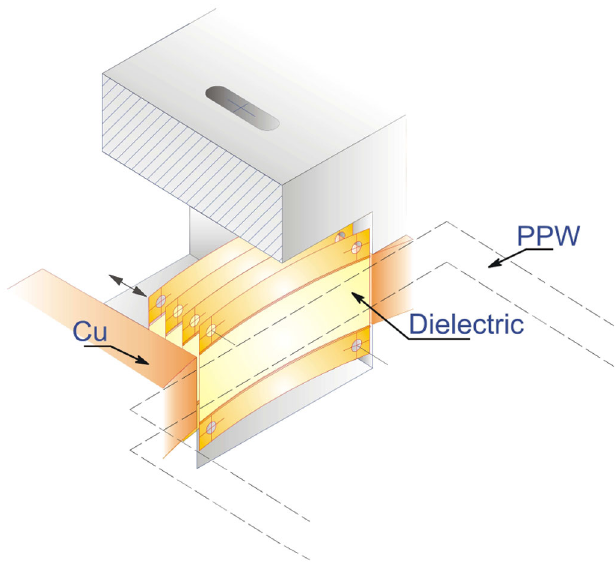
FIG. 5. (Color) Schematic of the multifunctional 1D PhC mirror. Separation between the layers is shown exaggerated for the sake of clarity. While the vertical confinement of the intracavity fields is provided by the low-loss PPW, the confinement in the hori- zontal plane is induced by the cylindrically shaped surfaces. The curvature is imposed on the layers by a pair of supporting metallic clamps. Layer thicknesses are 110 (cid:6) m for Q and 70 (cid:6) m for Si with a lateral extension of (cid:1) 45 mm . The surface of the first dielectric layer (facing the PPW) is flush with the adjacent polished Cu